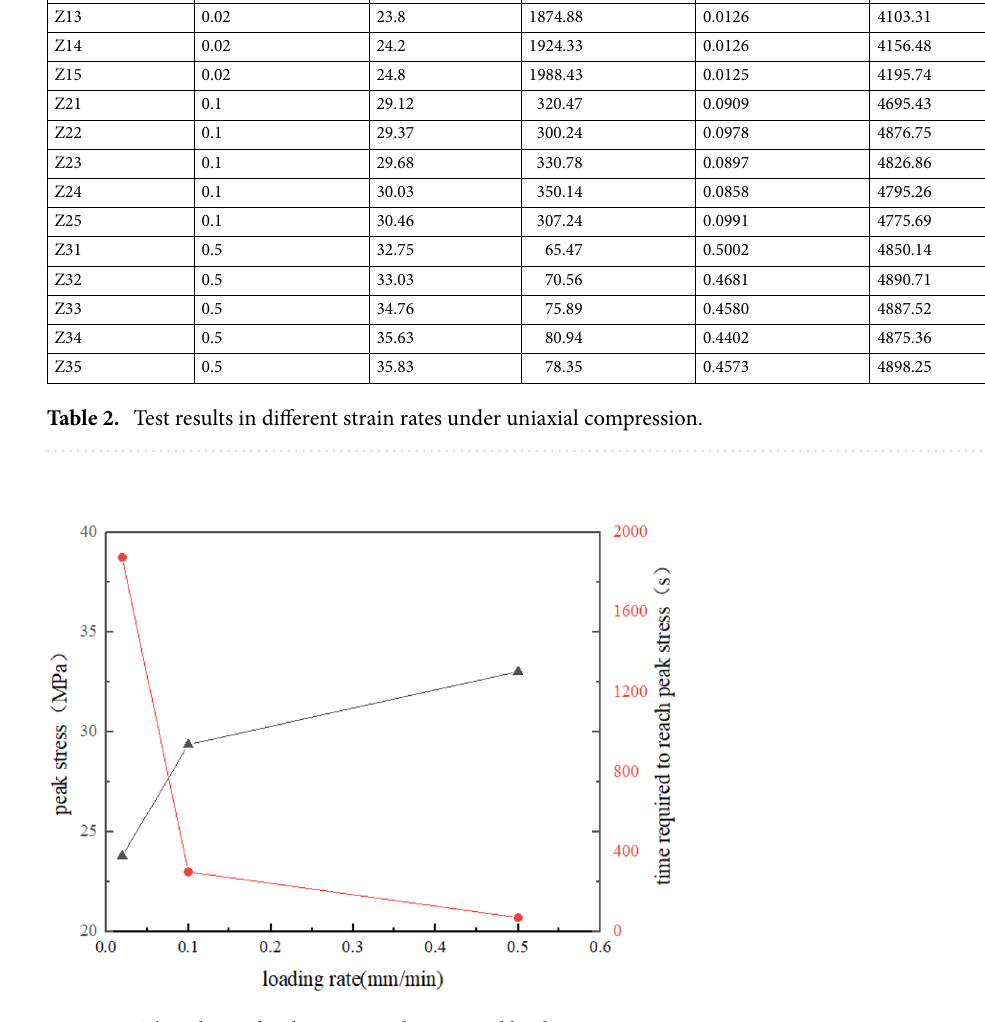
Figure 6. The relationship between peak stress and loading